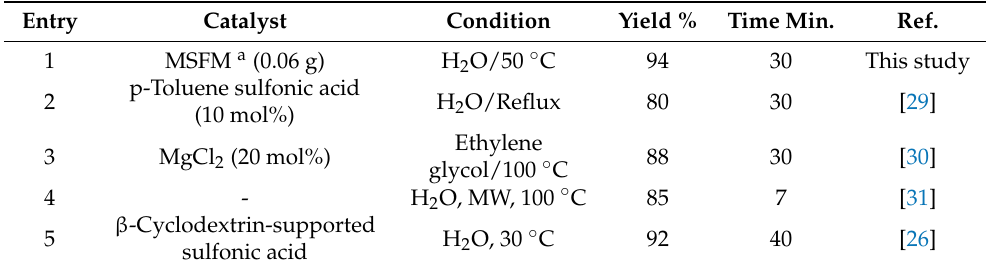
Table 4. Comparison of the catalytic efficiency of MSMF with various catalysts reported for the synthesis of 4a.